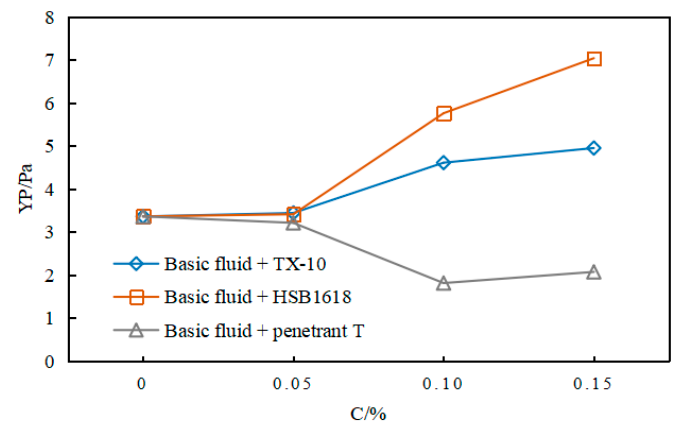
Figure 2. The yield point of solid-free drilling fluid.